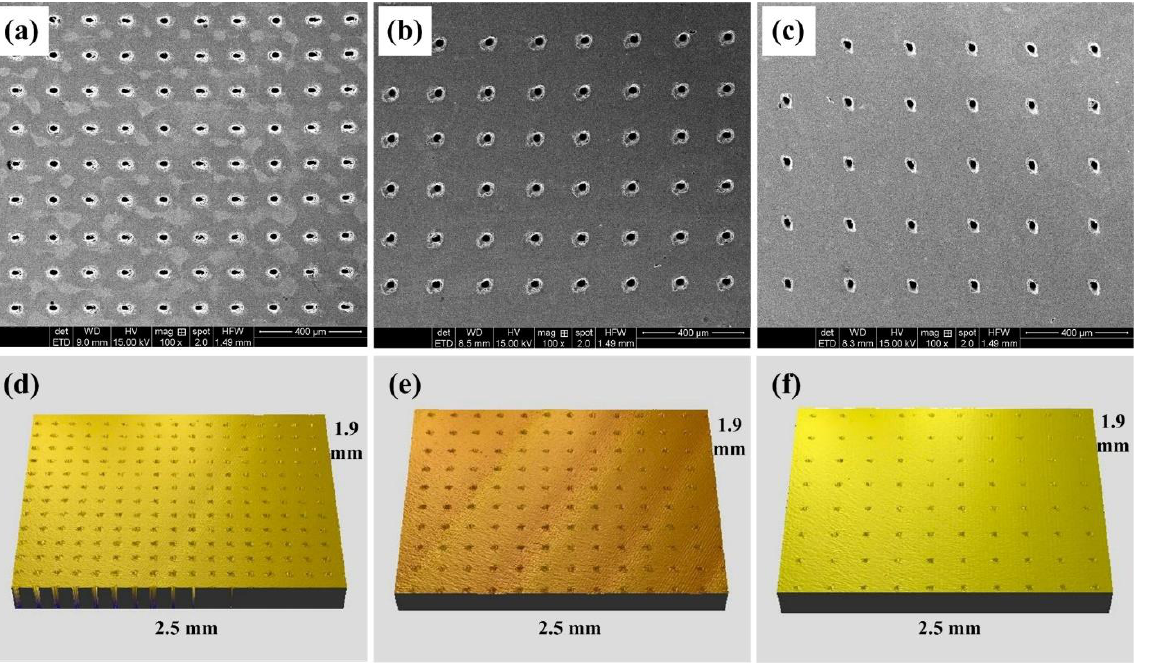
Figure 1. Morphology of textured dimples: ( a ) TD150, ( b ) TD200 and ( c ) TD250, as well as the corresponding stereoscopic topography: ( d ) 3D TD150, ( e ) 3D TD200 and ( f ) 3D TD250.